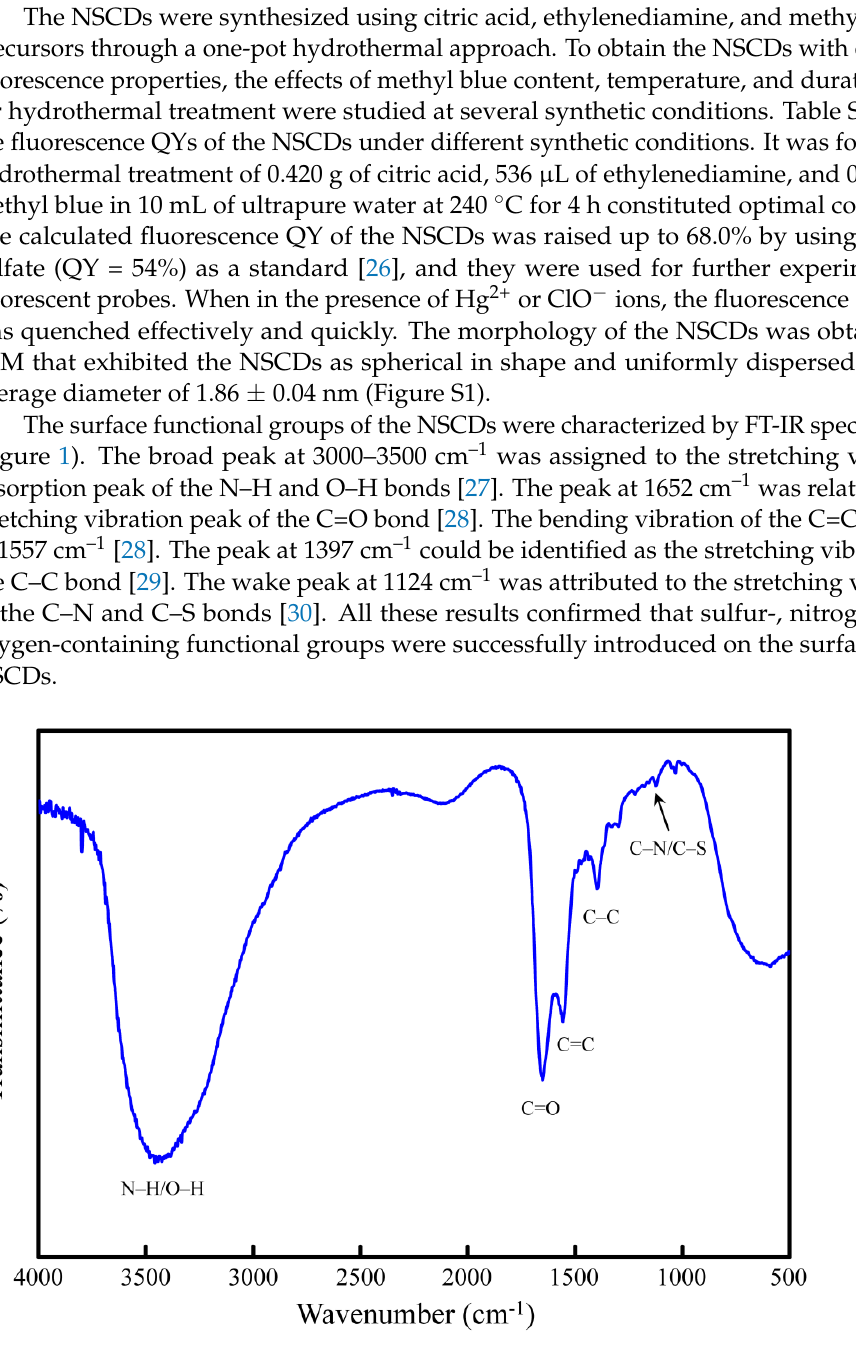
Figure 1. FT-IR spectrum of the NSCDs. The XPS measurements were further characterized as the elemental composition and chemical bonds of the NSCDs (Figure 2). The full-scan XPS spectrum (Figure 2a) of the NSCDs presented four peaks at 168.08 eV, 286.08 eV, 400.08 eV, and 532.08 eV,